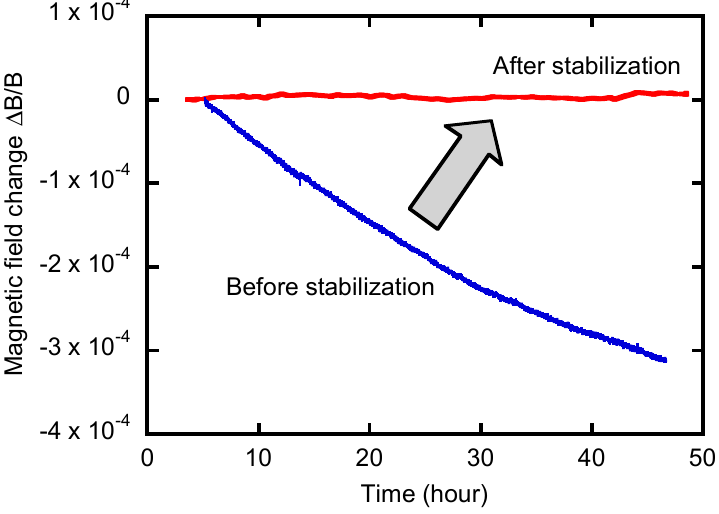
Figure 9. Comparison of the magnetic field change before and after stabilizing the magnet temperature of the cyclotron. A nuclear magnetic resonance (NMR) probe was used to precisely measure the magnetic field in the cyclotron.